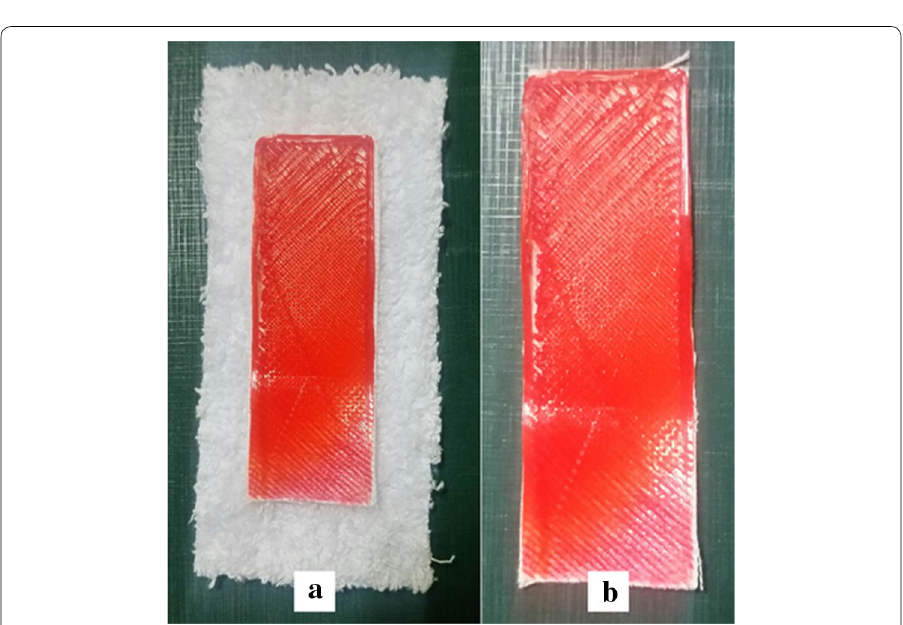
Fig. 2 PLA/cotton structure, a before cutting out the fabric parts around the composite and b prepared for loading on the tensile tester for adhesion